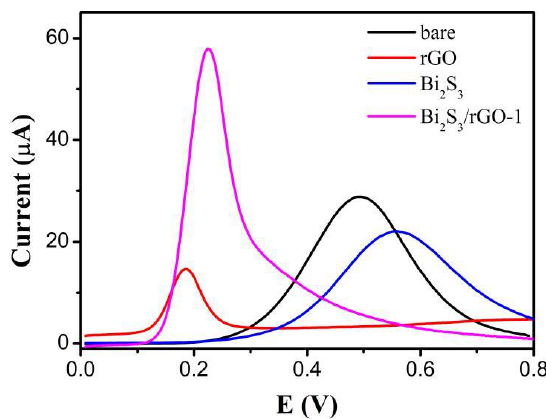
Figure 6. DPVs for bare GCE, Bi 2 S 3 /GCE, rGO/GCE, and Bi 2 S 3 /rGO-3/GCE in 0.1 M PBS (pH=7.0) with AA concentrations 5 mM.